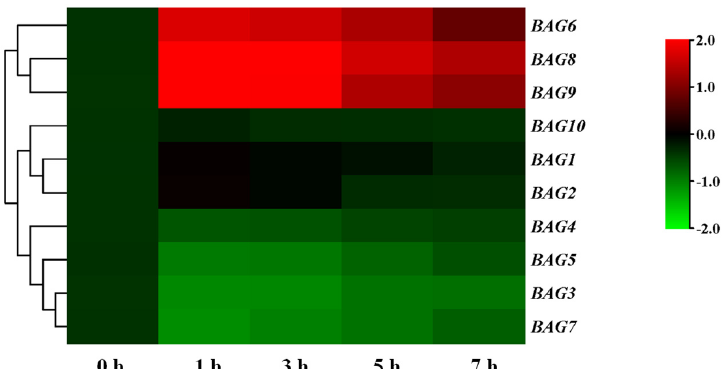
Figure 2. Transcripts of BAG genes in response to heat stress. Cluster analysis of expression patterns of BAGs under heat stress at 0 h, 1 h, 3 h, 5 h, and 7 h. The heat map was manufactured using log 2 logarithmic-transformed expression values. The color transition from red to green on behalf of high to low expression levels. According to the expression, the BAGs were clustered in the figure. The data represented the means ± SD of three biological replicates.